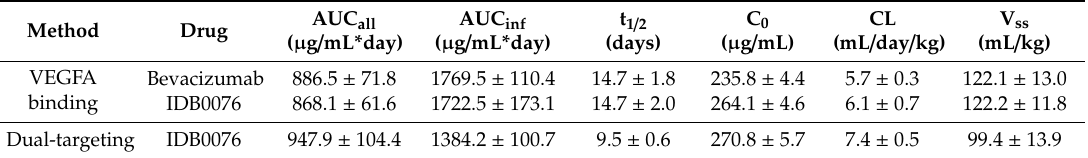
Figure 3. IDB0076 retains the binding affinity for VEGFA and NRP1 simultaneously in the pharmacokinetic (PK) assay. ( a ) Sprague–Dawley (SD) rats received a single i.v. injection of 10 mg/kg IDB0076 or bevacizumab via the tail vein. The serum concentrations of IDB0076 and bevacizumab are presented, as determined based on their binding activity for immobilized human VEGFA in an enzyme-linked immunosorbent assay. ( b ) The serum concentration of IDB0076 was measured based on its binding activity for immobilized VEGFA and was determined by means of the biotinylated NRP1 b1b2 domain. Each symbol and error bar represent the arithmetic mean and the standard deviation of each drug at a given time point ( n = 5). Table 2. Pharmacokinetic (PK) parameters estimated by noncompartmental analysis after a single intravenous (i.v.) injection of 10 mg/kg IDB0076 or bevacizumab into Sprague–Dawley (SD) rats according to the assay methods.